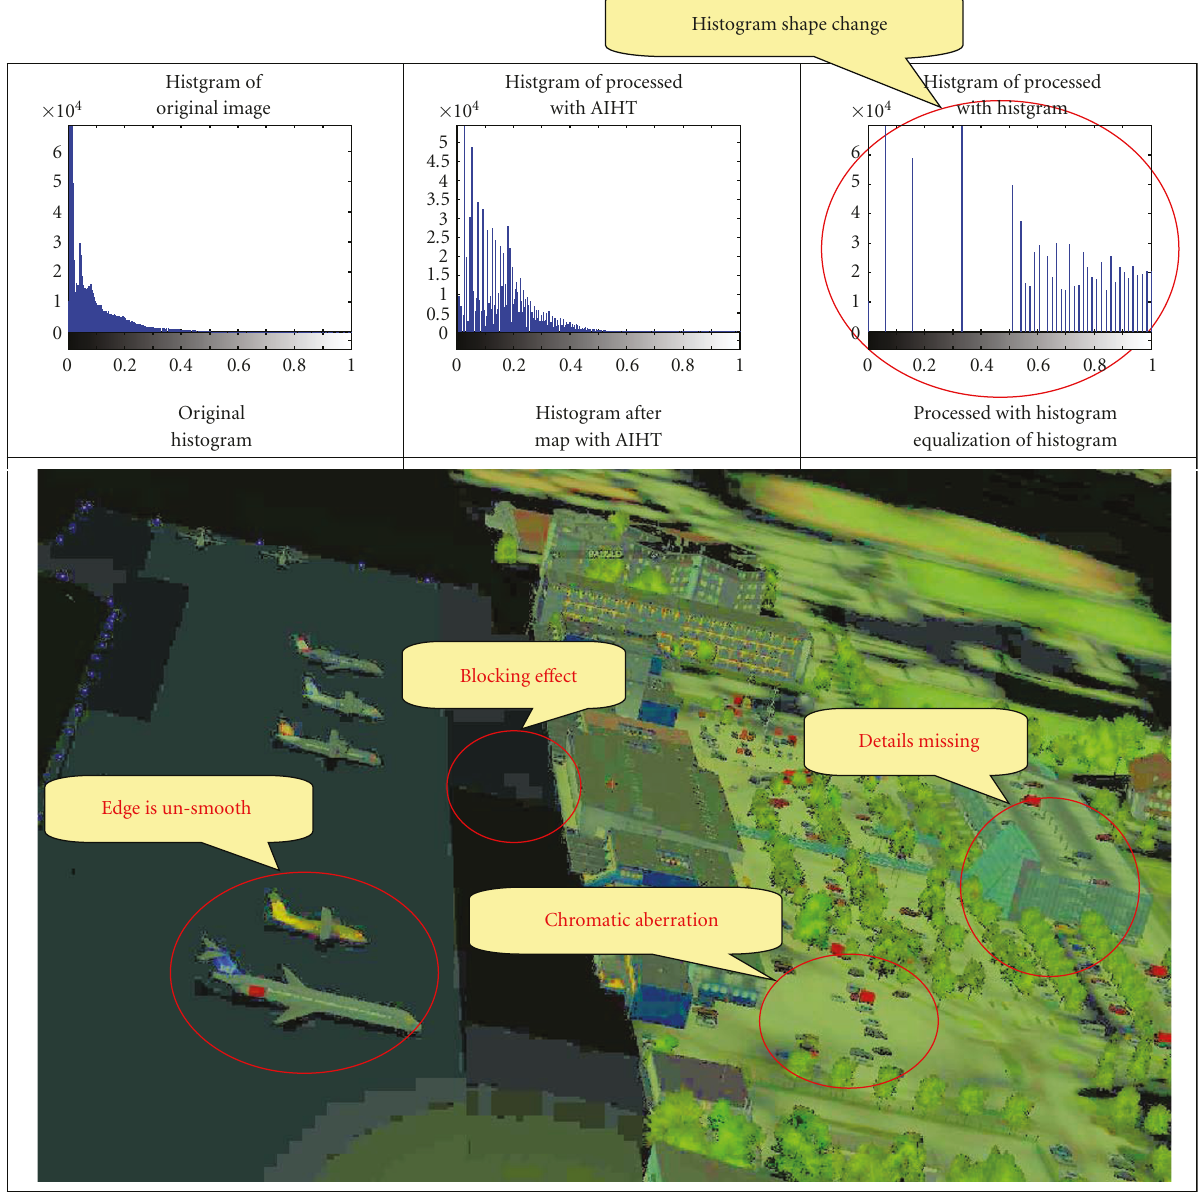
Figure 20: Histogram equalization